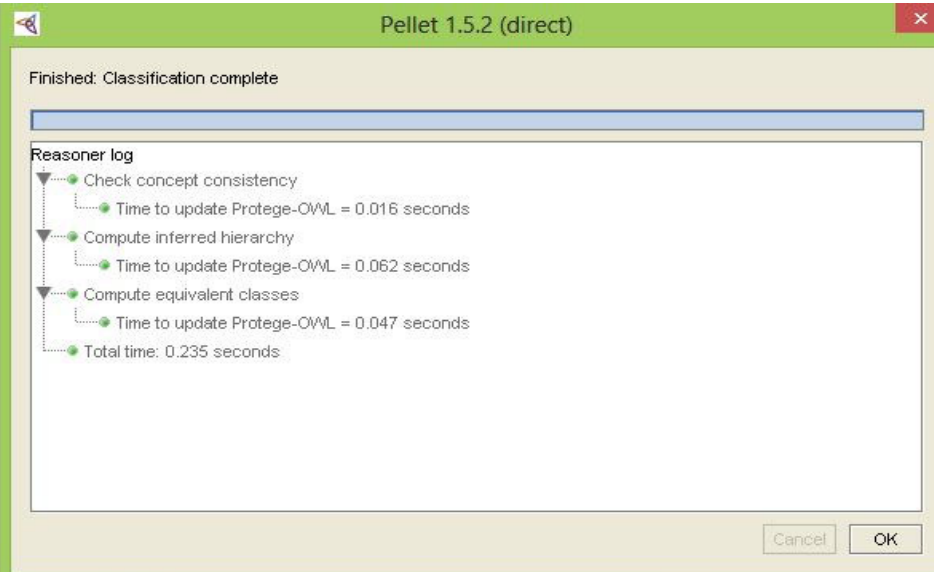
Figure 3. Verification of the semantic and grammatical